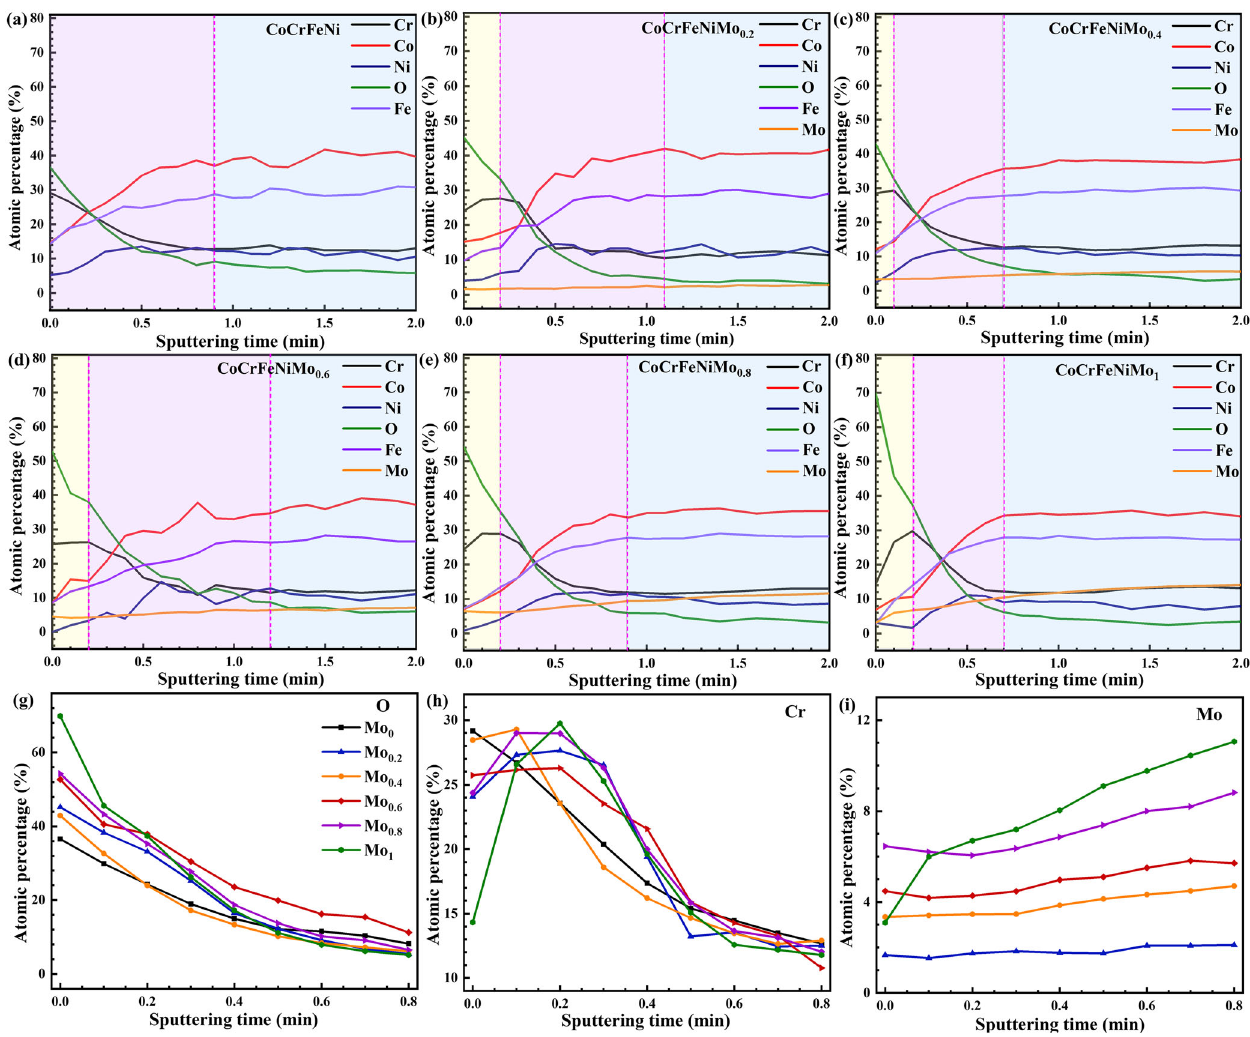
Fig. 9 XPS depth pro fi les of the elements in the passive fi lms. XPS depth pro fi les of the elements in the passive fi lm after the potentiostatic polarization at 0.4 V SCE for 10 h in 5 mM H 2 SO 4 solution, a Mo 0 , b Mo 0.2 , c Mo 0.4 , d Mo 0.6 , e Mo 0.8 , and f Mo 1 , as well as the comparison in element g O, h Cr, and i Mo